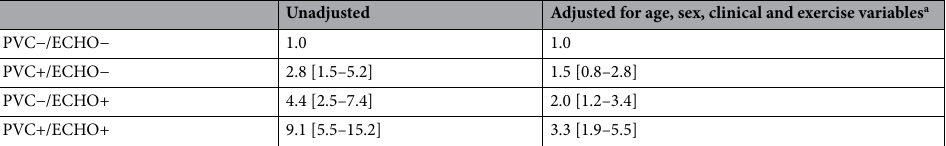
Unadjusted Adjusted for age, sex, clinical and exercise variables